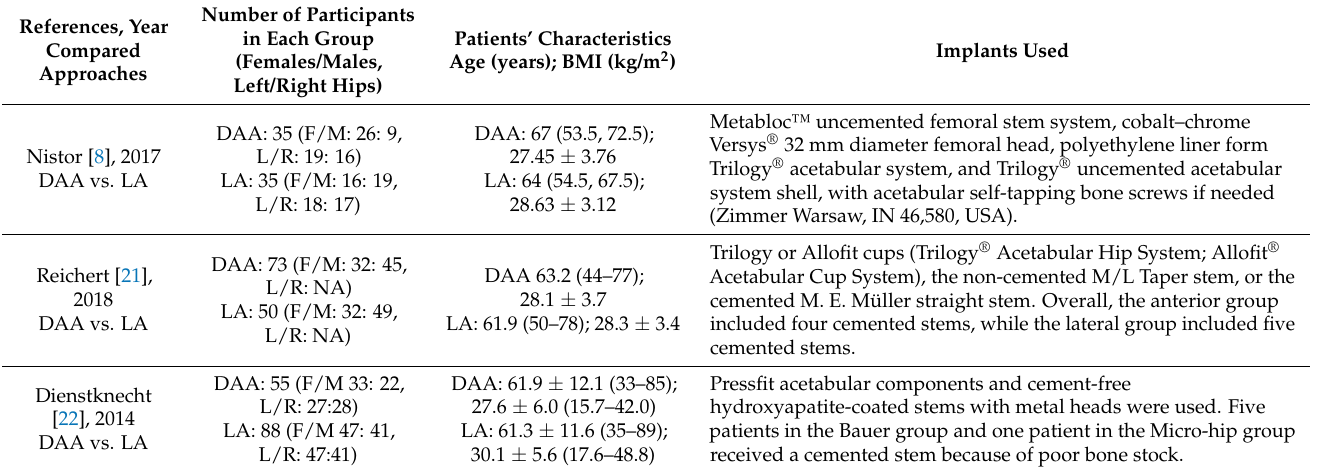
Table 2. Participants’ characteristics in analyzed